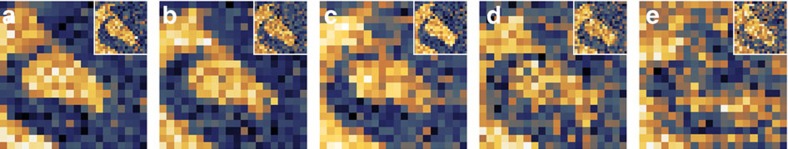
Effect of varying helium mean beam energy on sample contrast.(a–e) 83, 72, 66, 42, and 21 meV SHeM micrographs of the 15-nm-thick gold on silicon sample. All images were taken with the sample at the specular position, with a 200 bar beam and the sample at room temperature (294 K). Insets show simulated images with Poisson noise added, according to the observed count rates. Note that the contrast is maintained in the simulations, but lost in the data, which confirms the presence of an additional contrast mechanism.